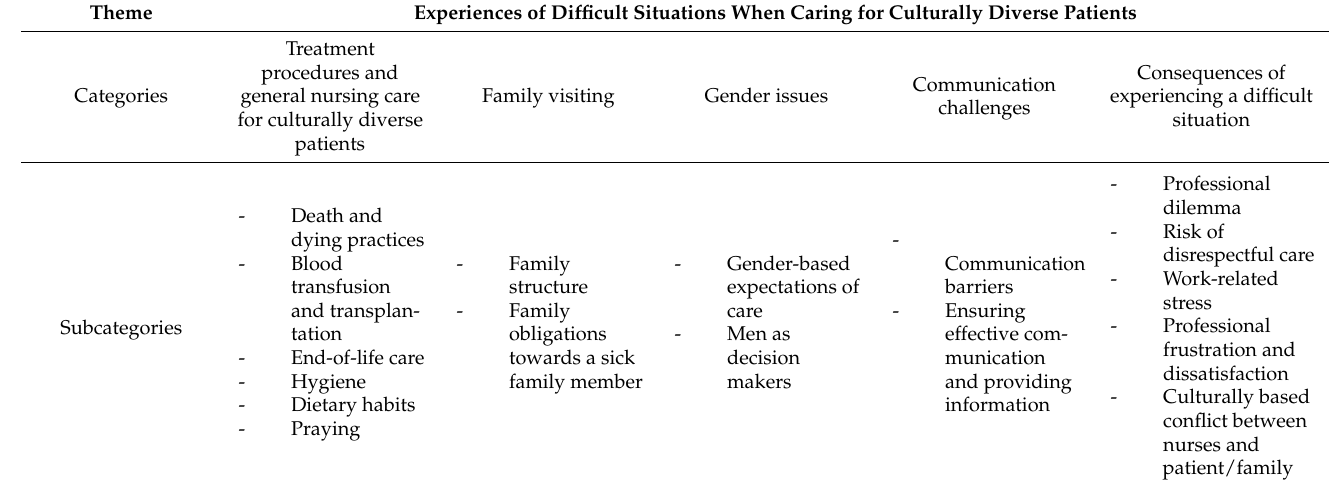
Table 7. Experiences of a difficult situation when caring for culturally diverse